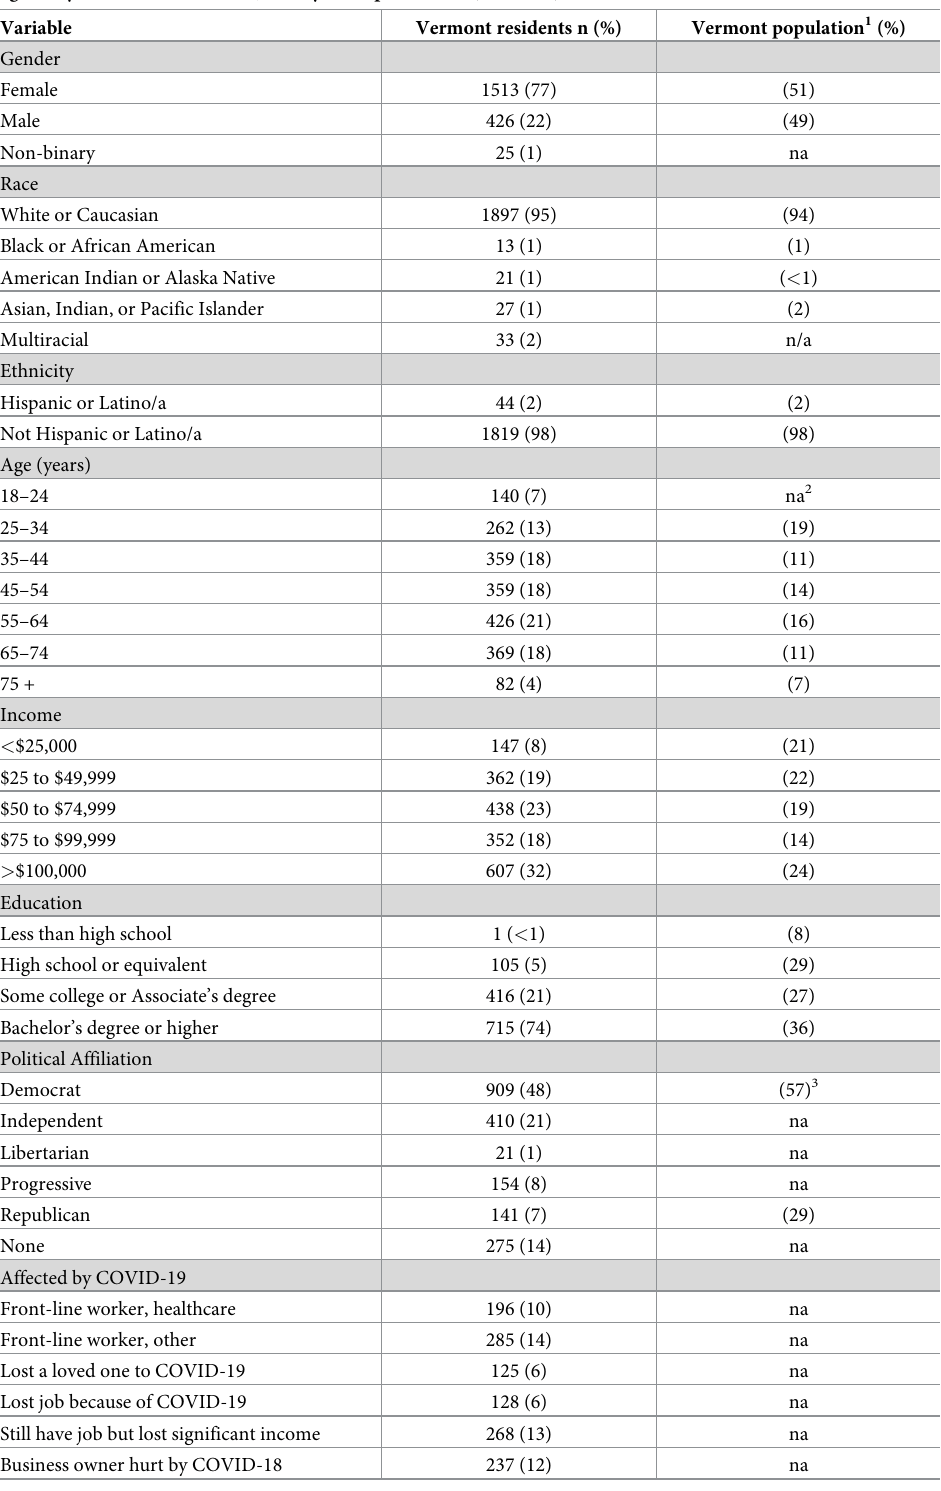
Table 1. Characteristics of respondents to survey on Vermont’s COVID-19 Guidelines among state residents aged 18 years or older between January 13 –April 7, 2021 (n =